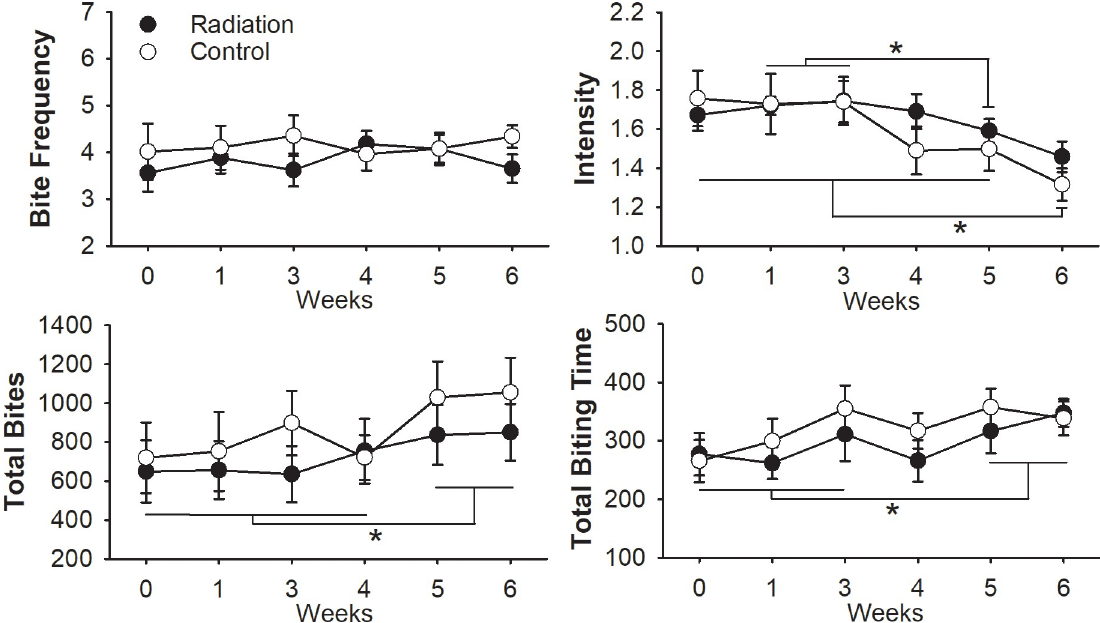
Fig 4. Changes in biting performance across time taken from the pasta biting tests. Biting was analyzed at baseline (0), during radiation (1-, 3-, and 4-weeks), and after completion of radiation (black) or sham (white) treatment (5- and 6-weeks). Results demonstrate the mean and standard deviations for bite frequency (Hz), intensity (dB), total bits, and the total biting time (seconds). No differences (p > 0.05) between groups were observed. Significant main effect for time was indicated by